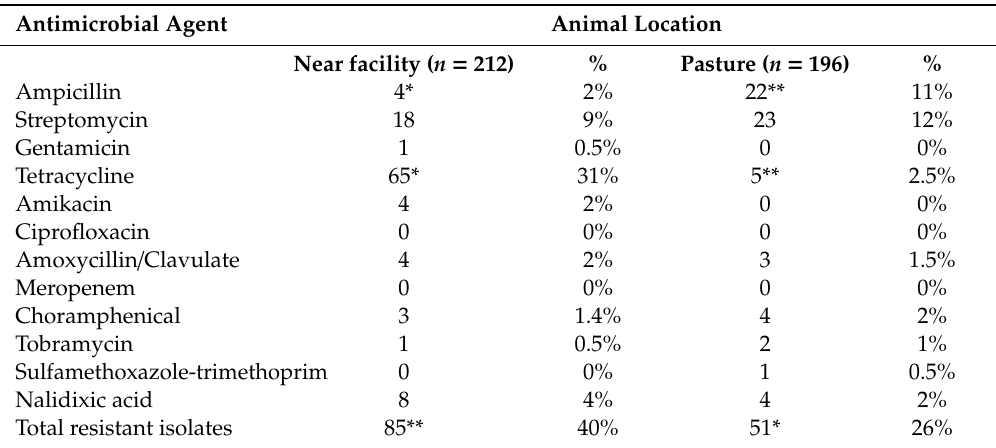
Table 4. Resistance phenotype and the respective percentages of E. coli isolates detected in pastured goats at di ff erent locations at the research farm. Antimicrobial Agent Animal Location Near facility ( n = 212) % Pasture ( n =